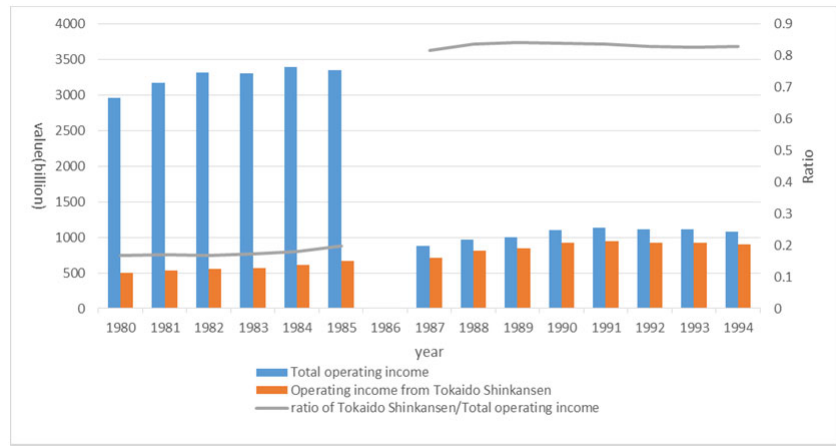
Figure 2. Total income and income from Tokaido Shinkansen Source: Created by the author on the basis of Imamura (1997), Inoue (2014), Sueyoshi, Machida, Sugiyama, Arai, and Yamada (1997). The national railways were broken up, and the figures for 1986 are